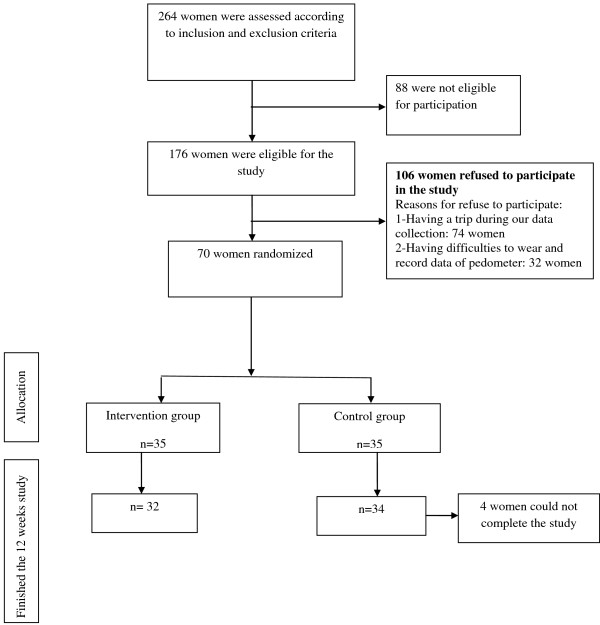
Flow diagram of recruitment and retention of participants in the study.